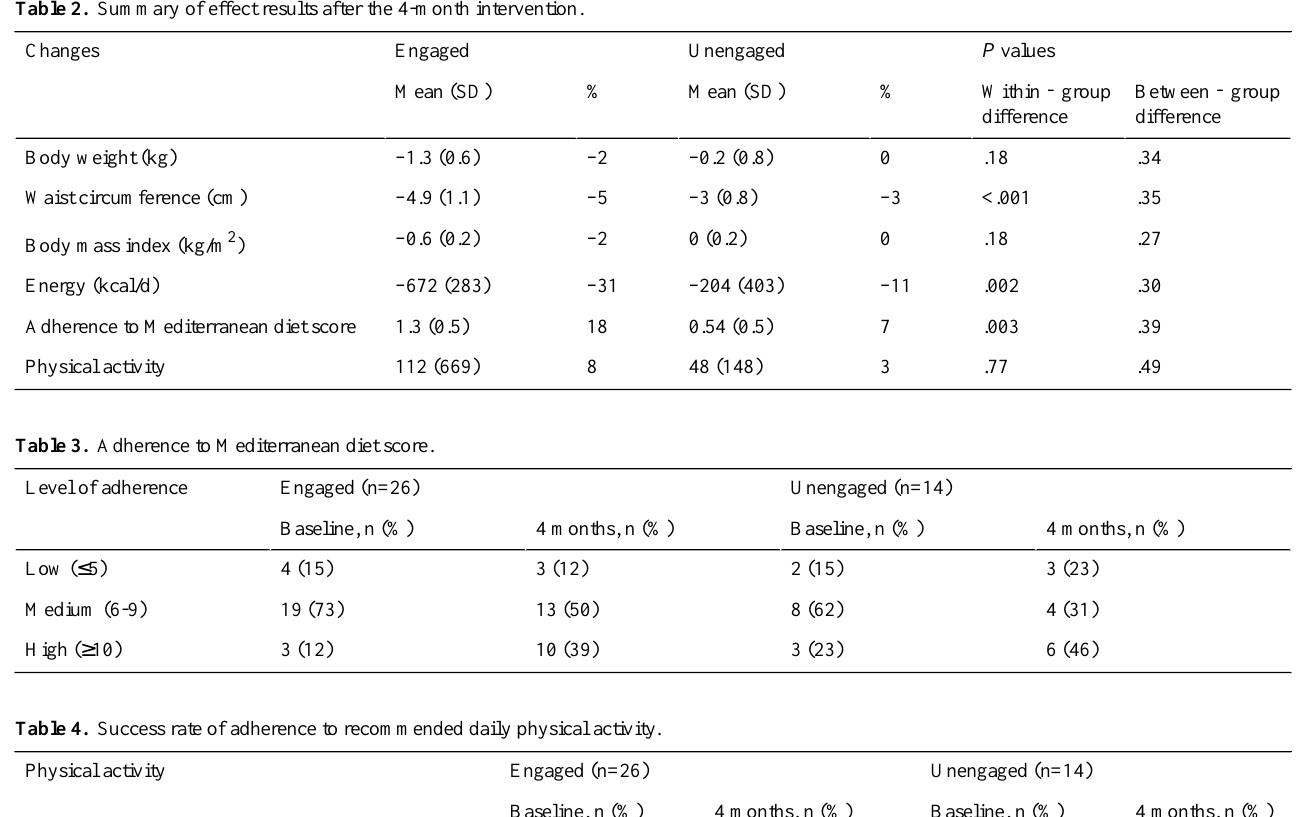
Table 2. Summary of effect results after the 4-month intervention.